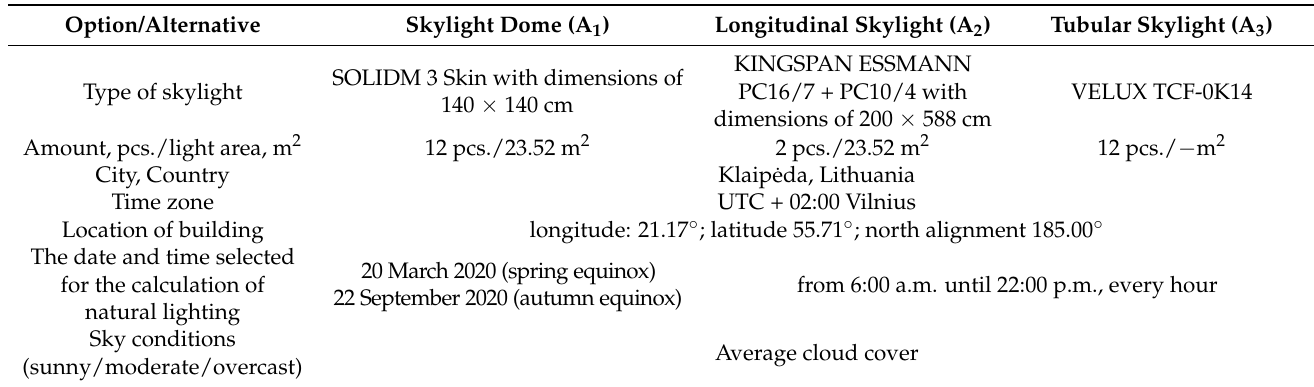
Table 3. Parameters used for the calculation of natural